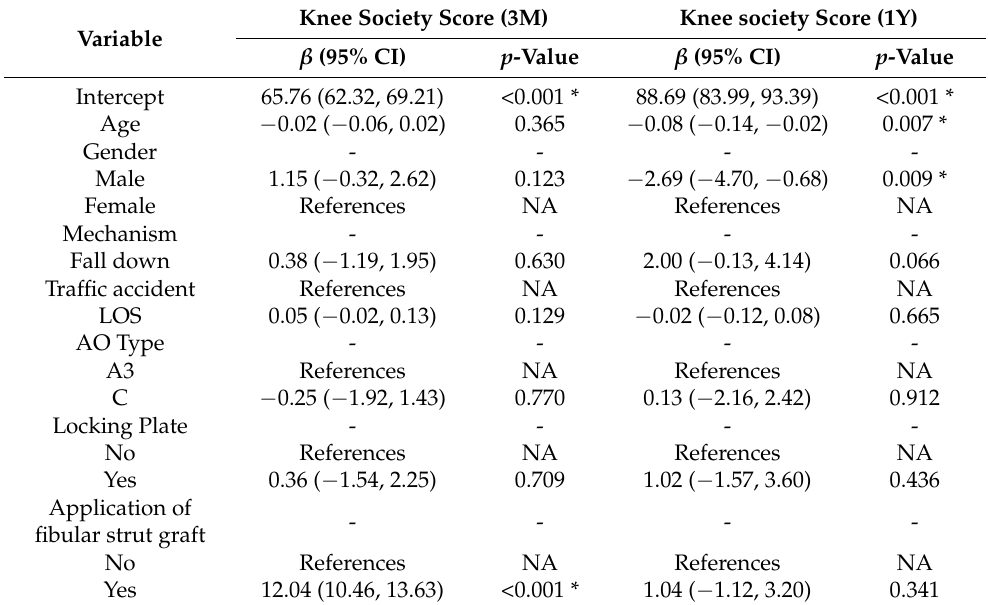
Table 3. Factors associated with knee society score at 3 months and 1year after operation among patients ( n =